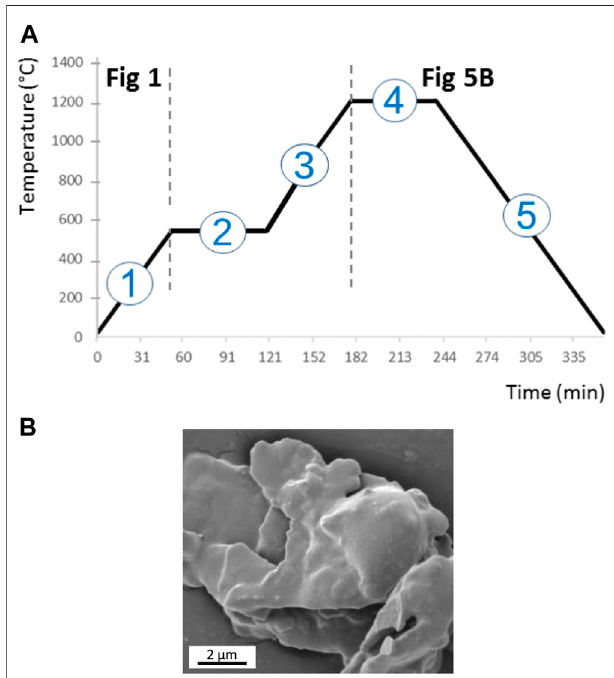
FIGURE 5 | From hydrated kaolin to pseudo-ceramic: (A) thermal history, (B) morphology after thermal sintering. Depending of the nature of the system, variety of higher temperature mineral phases may